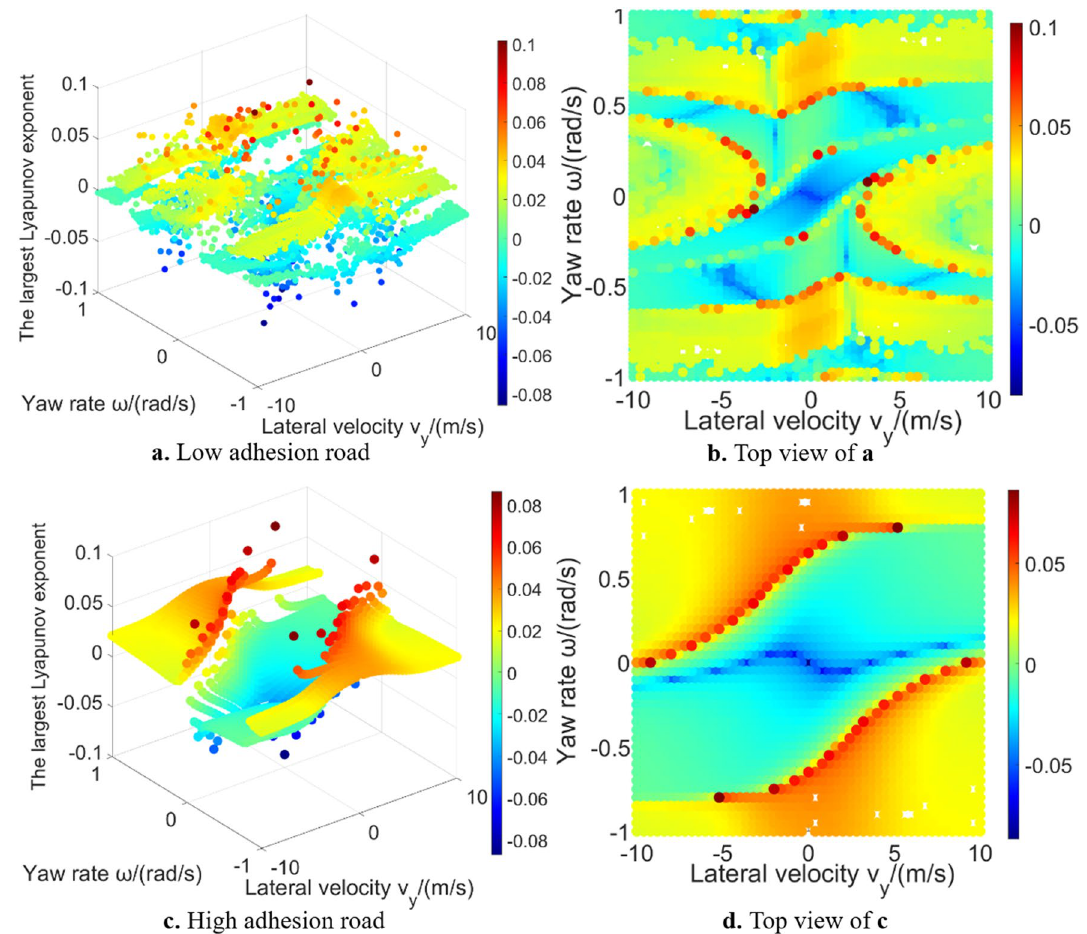
Figure 13. The largest Lyapunov exponent in the 5-DOF model global